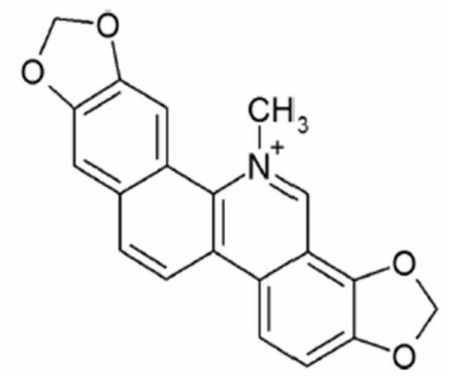
Figure 1. Chemical structure of